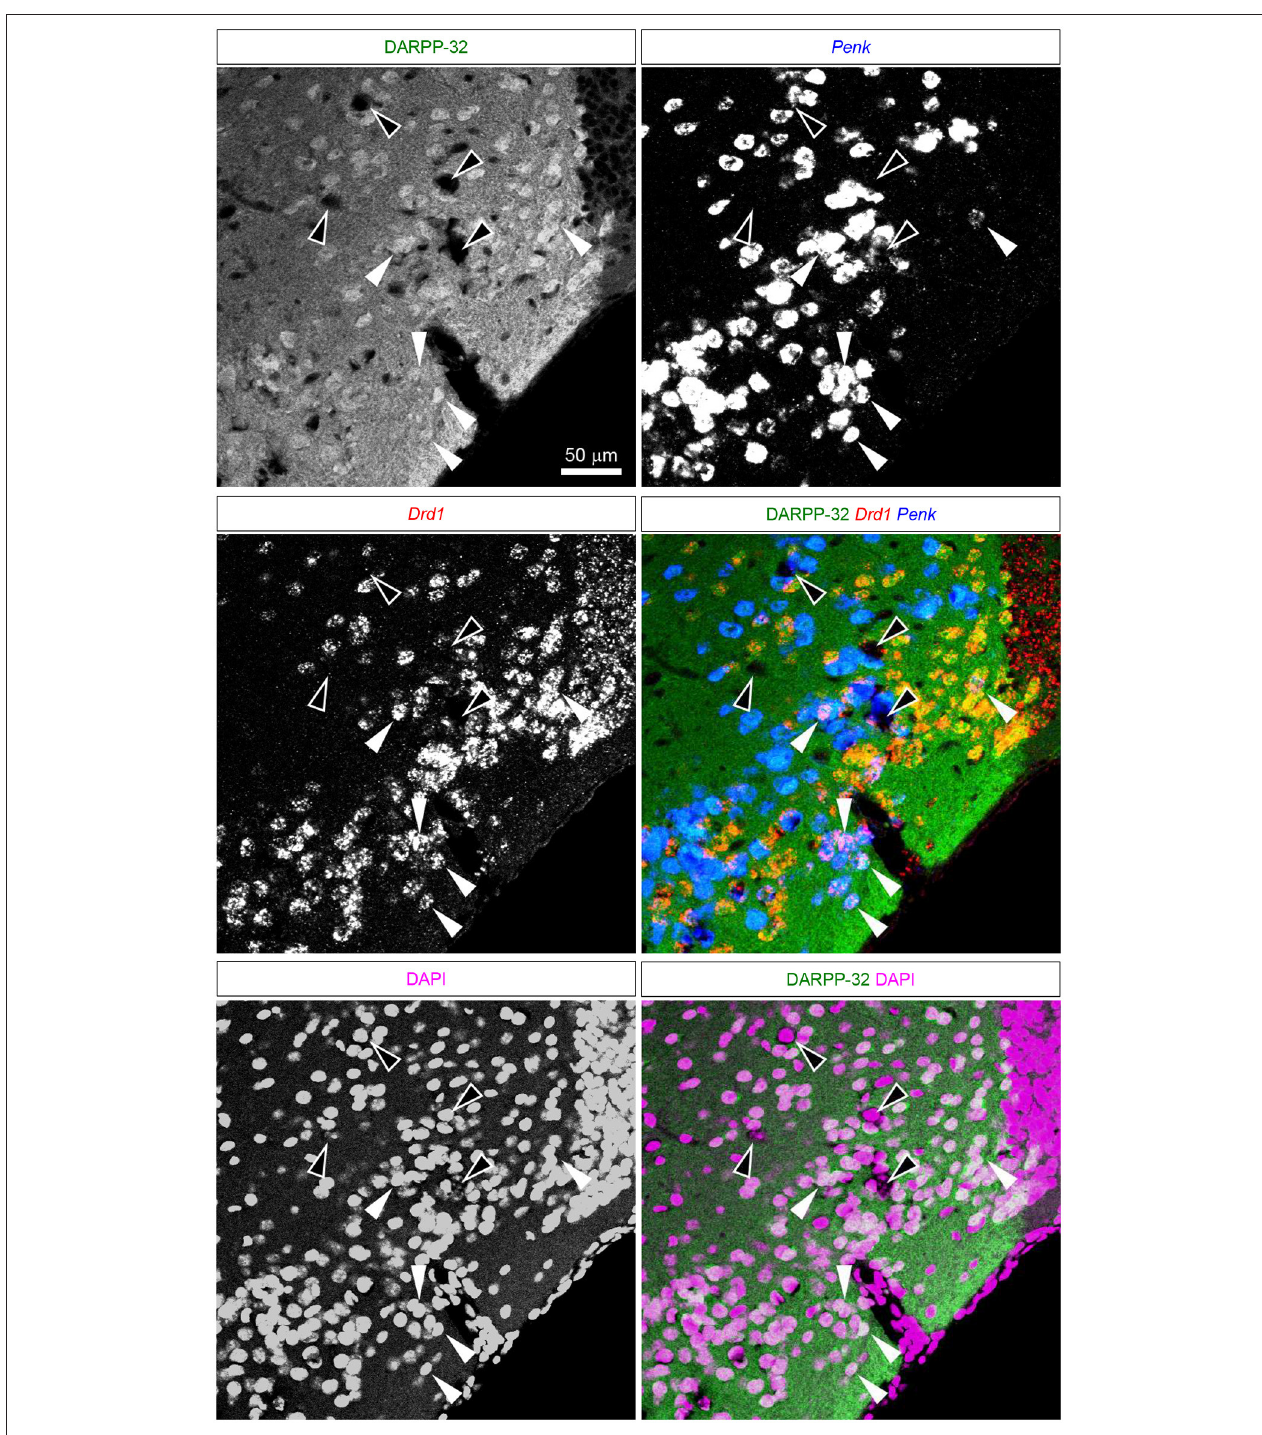
FIGURE 8 | DARPP-32 expression by the putative Pdyn-Penk-Drd1 co-expressing cells in the anteromedial DCL. Fluorescence images of DARPP-32 immunoreactivity (upper left, green), Penk (upper right, blue), Drd1 (middle left, red) mRNA signals, DAPI (lower left, magenta), and color merged view (middle right; DARPP-32-Drd1-Penk, lower right; DARPP-32-DAPI) in the same region. White arrowhead shows the colocalization of the DARPP-32 immunoreactivity and Penk-Drd1 mRNAs. White-outlined arrowheads indicate the colocalization of Penk-Drd1 signals, which did not colocalize with DARPP-32 immunoreactivity.